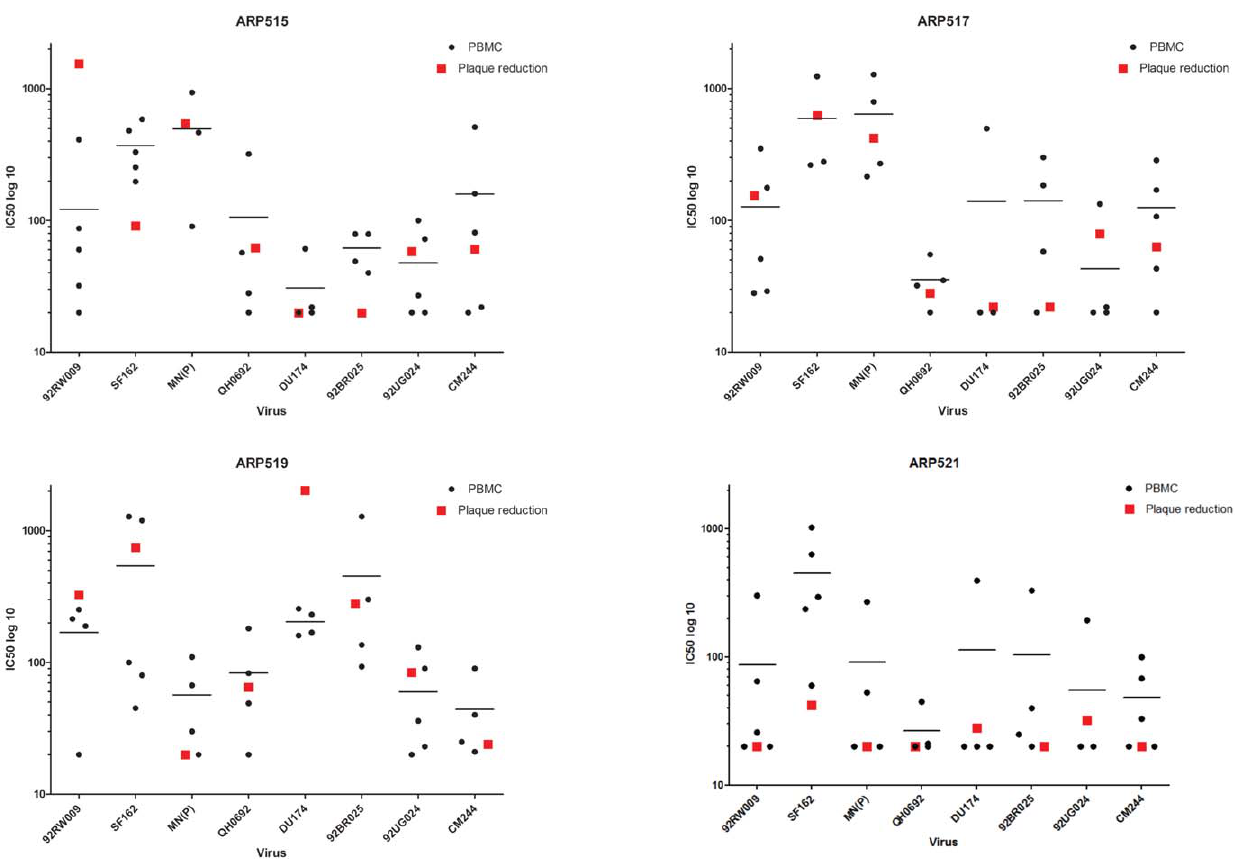
Figure 5. Comparison of PBMC assay with the automated readout of the plaque reduction assay. Plaques, identified as GFP-expressing cells, were evaluated by use of an AxioVision Z1 Microscope with automated reading platform. The 96-well plates were screened through with illumination time of 200 ms throughout experiments. To reduce auto fluorescence, medium was removed and PBS was gently added pre-microscopy. Plaque quantity was measured with CellProfiler software ( [32] (www.cellprofiler.org), version r10997. Image analysis was performed using fifteen 5 6 mosaic images per well. Results presented are the means of 2–3 experiments. Black dots, IC50 obtained by individual laboratories in the PBMC assay; red squares, IC50 obtained in the plaque reduction assay.